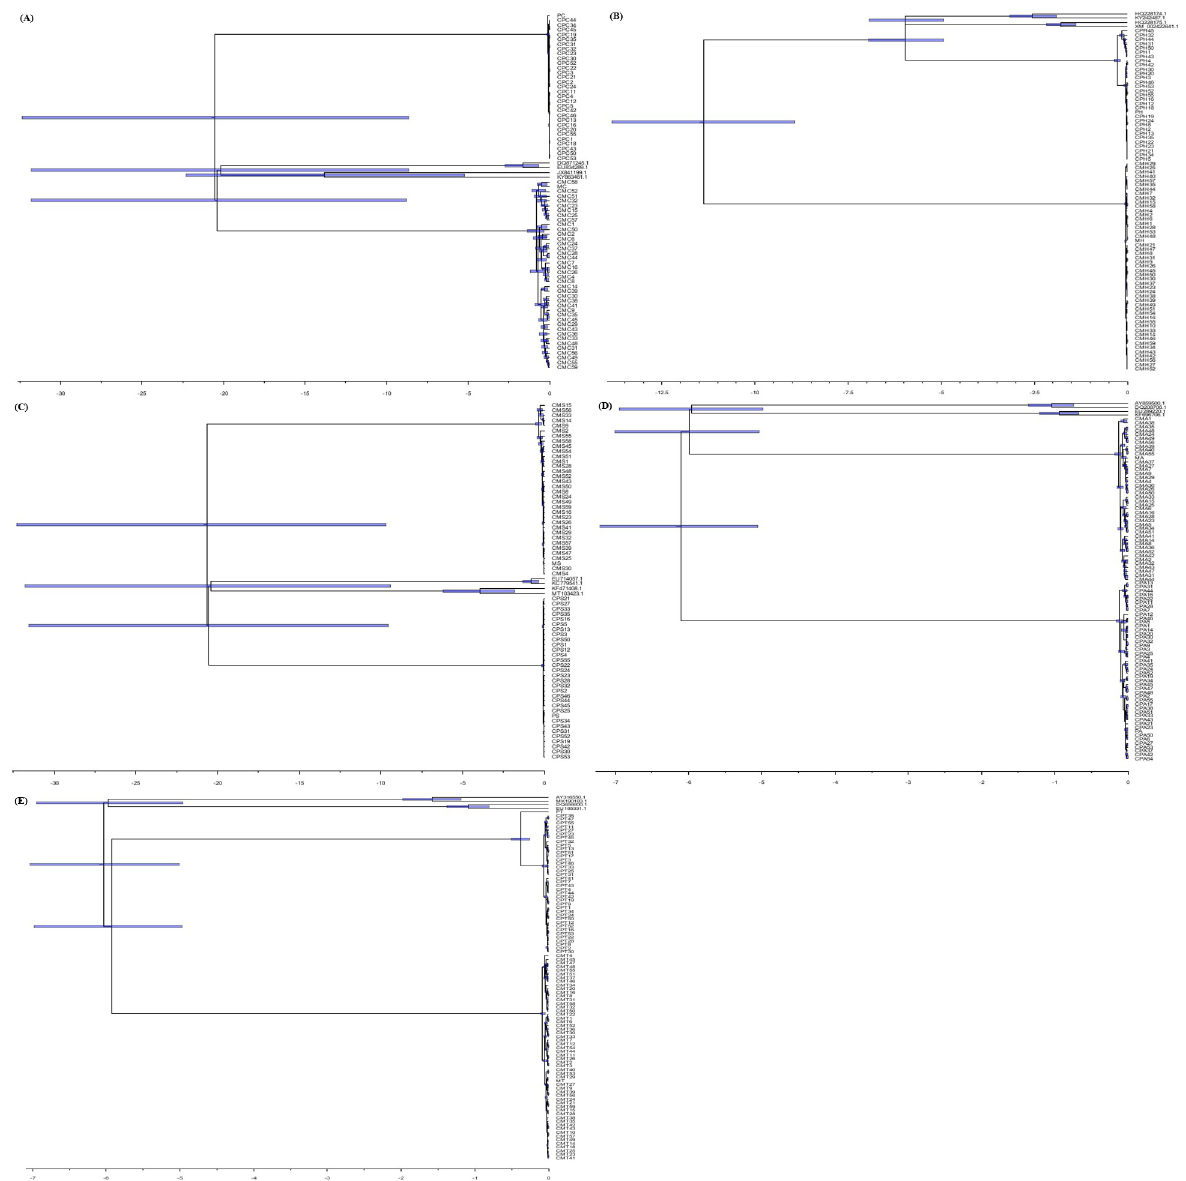
Fig 4. Bayesian molecular clock inference using BEAST2 software. A: C-type Lectin, B: HMGB, C: STAT, D: ALF3, E: ATPase 8/6. (Gamma site model; Relaxed clock log normal; Chain length: 10000000 or before infinity and ESS > 200). [Models used: A (HKY+G), B (TrN+G), C (HKY+G), D (HKY+G), E